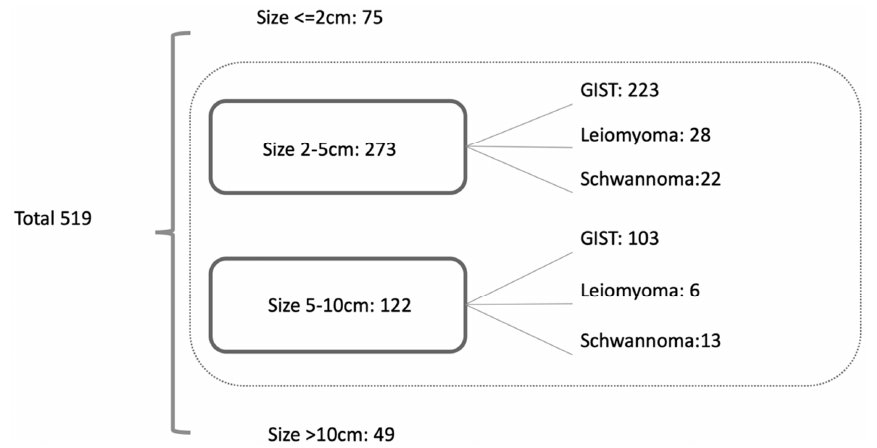
Figure 1. Distribution of GSETs.